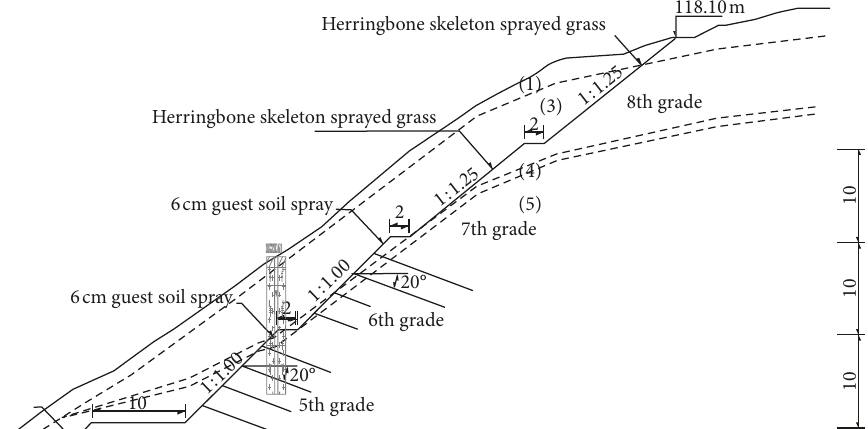
Figure 2: Distribution of slope strata. (1) Silty clay, (2) fully weathered granite, (3) strongly weathered granite, (4) moderately weathered granite, and (5) microweathered granite.